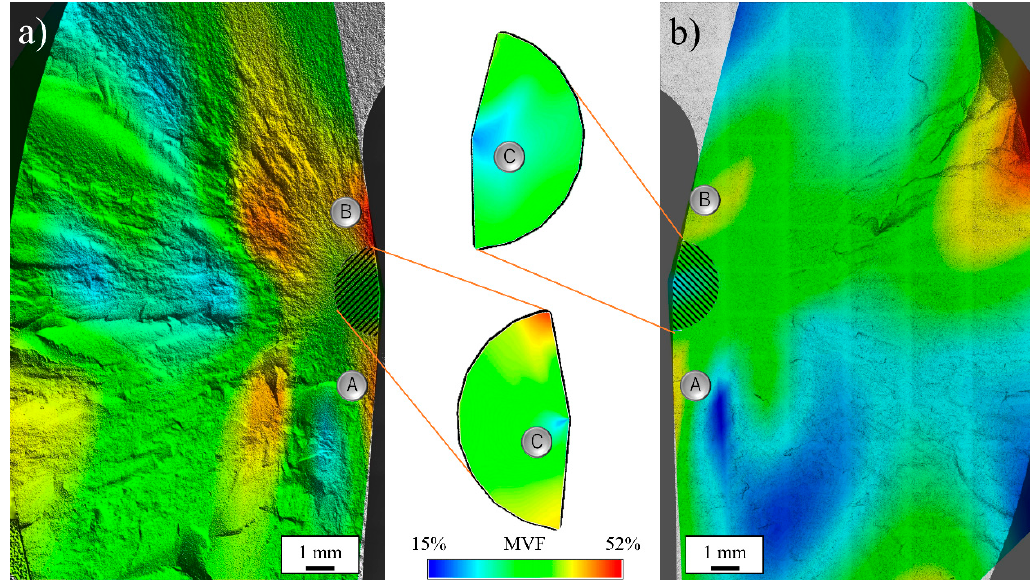
Figure 8. Monoclinic volume fraction (MVF) as measured by Raman spectroscopy using the Katagiri equation, as a function of portion on the primary fracture surface for a ( a ) Group 2 and a ( b ) pristine femoral head tested against CoCr trunnions.